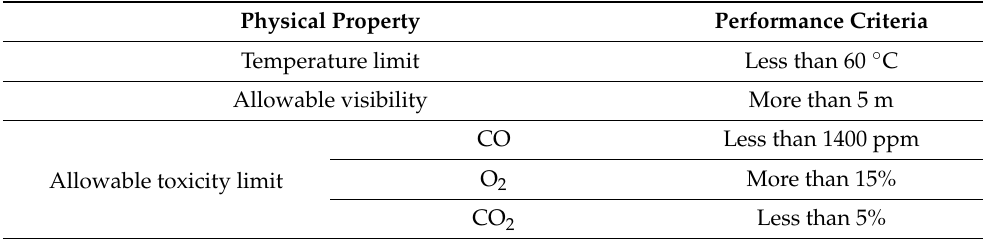
Figure 2. Floor plan of prototype nursing hospital. Table 1. Tenability criteria in NFPA [29].